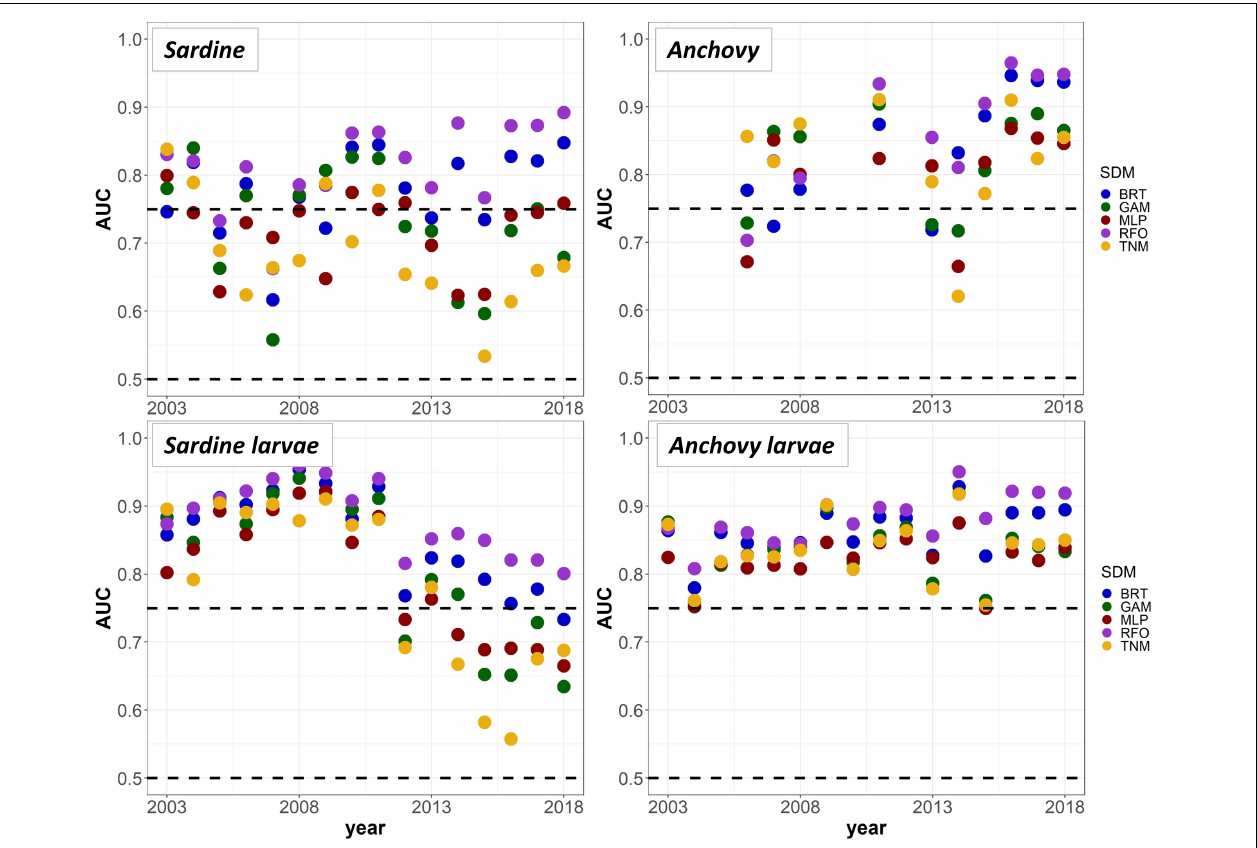
FIGURE 9 | Mean Area Under the Receiver Operating Curve (AUC) test skill metrics for SDMs trained on random 50% splits of all available data from 2003 to 2018, for the “all” covariate configuration only. Colors denote the SDM type. The horizontal black dashed lines show AUC values of 0.5 (no better than a random model), and 0.75 (a rough approximation of a “useful” model), for